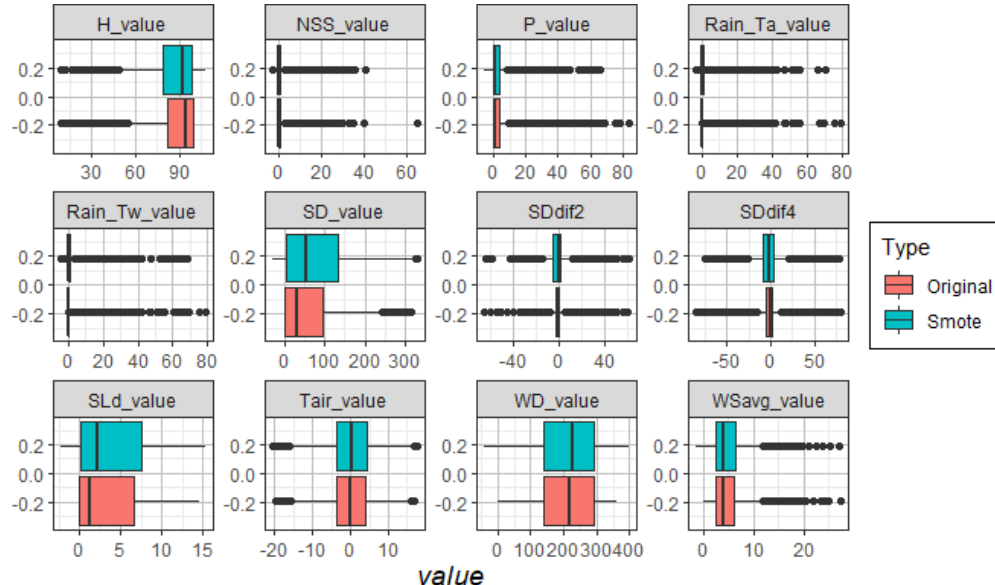
Figure A1. Boxplot of wet avalanches of original and synthetic (SMOTE) data.